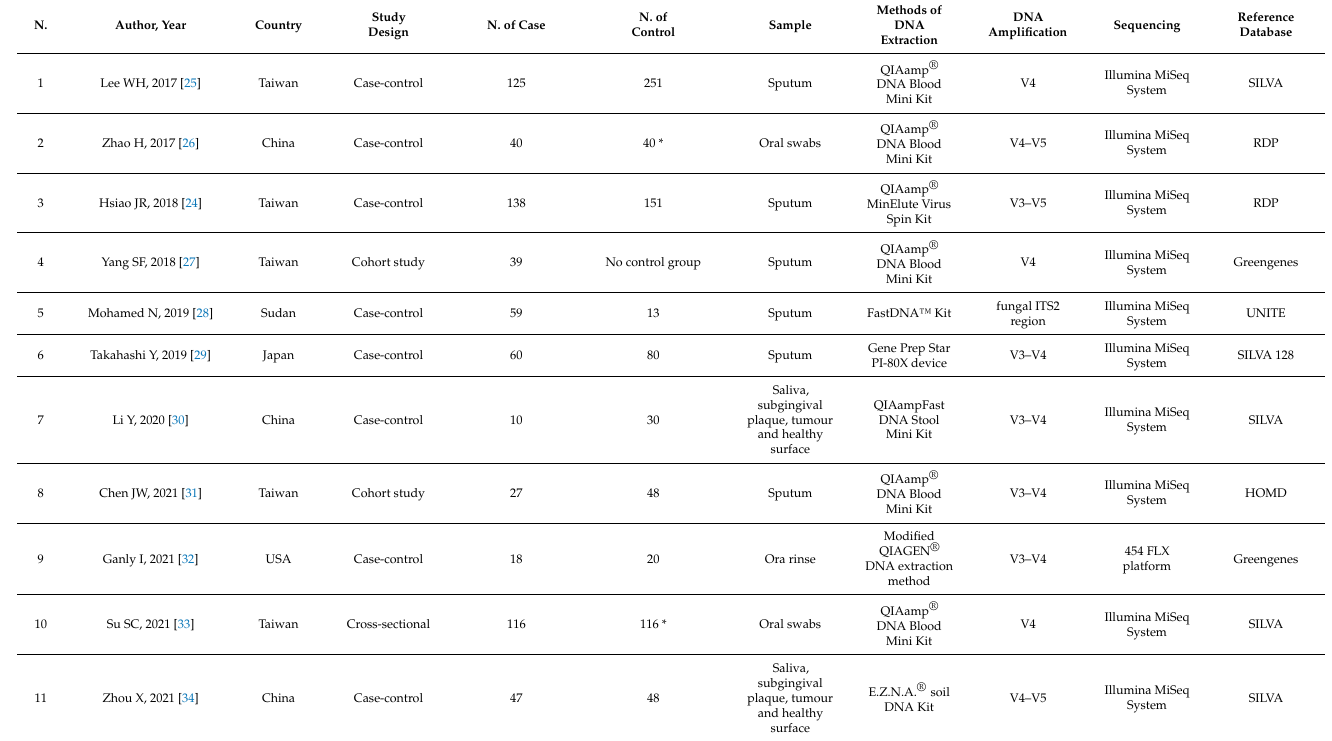
Table 1. Characteristics of the included studies and the methodology employed for the analysis of the salivary